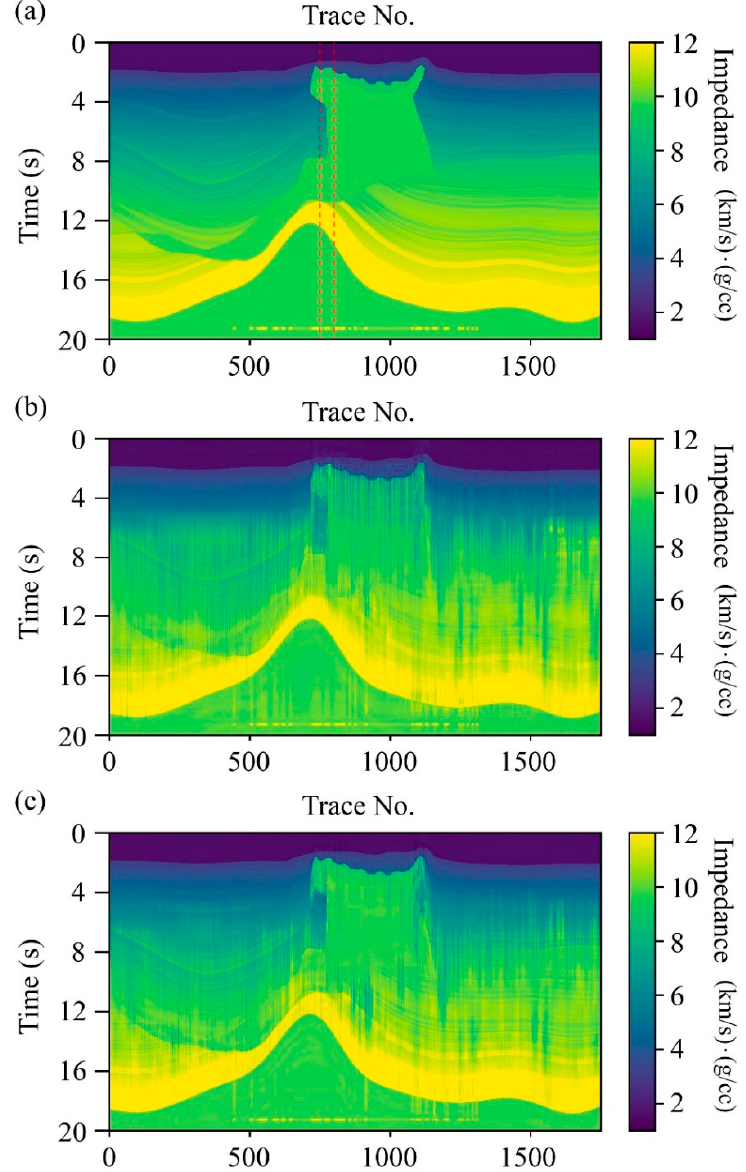
Figure 7. Predicted impedance and true impedance of SEAM model: ( a ) true impedance; ( b ) impedance predicted CNN method; ( c ) impedance predicted by proposed method.